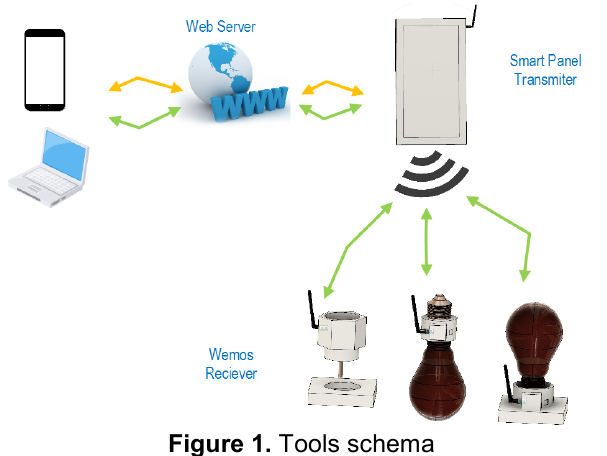
Figure 1. Tools schema